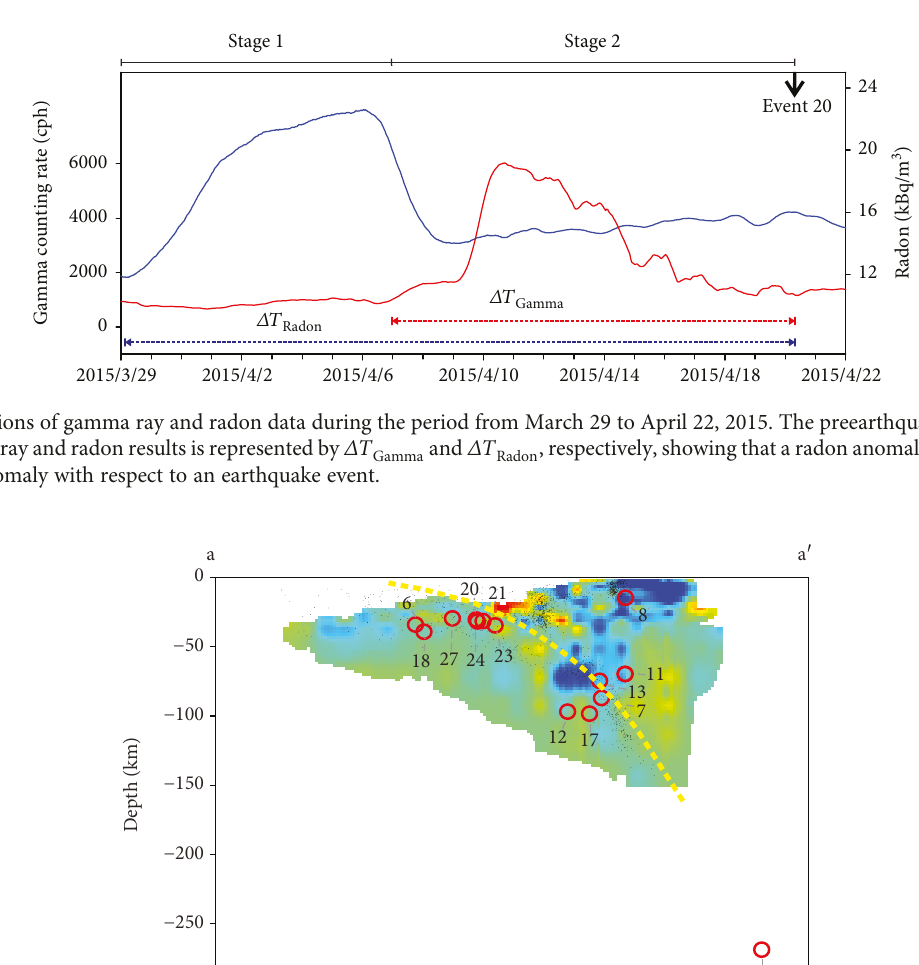
Figure 6: The seismic velocity structure transecting northern Taiwan along the a-a ′ line of Figure 1 is derived based on the local earthquake tomography model by Wu et al. [53]. The dots show the relocated events for M > 3 within ± 5km of the pro fi le. The red open circle means that the projected earthquake with a preanomalous signal is listed in Table 2. Note that the hypocenters get deeper towards the north. The yellow dashed line indicates the subduction boundary between the PSP and the EP.